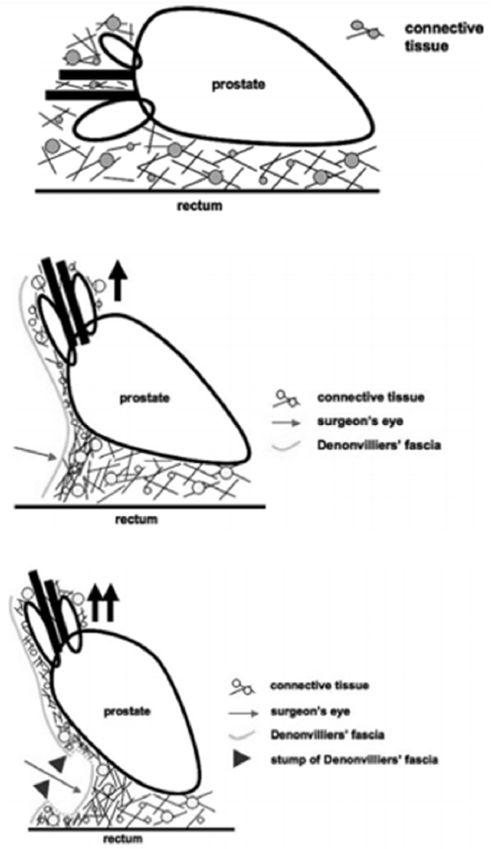
Figure 3. Intraoperative identification of Denonvilliers’ fascia by pulling the prostate ventrally. Reprinted with permission from [44]. Copyright 2021 Spandidos Publications.